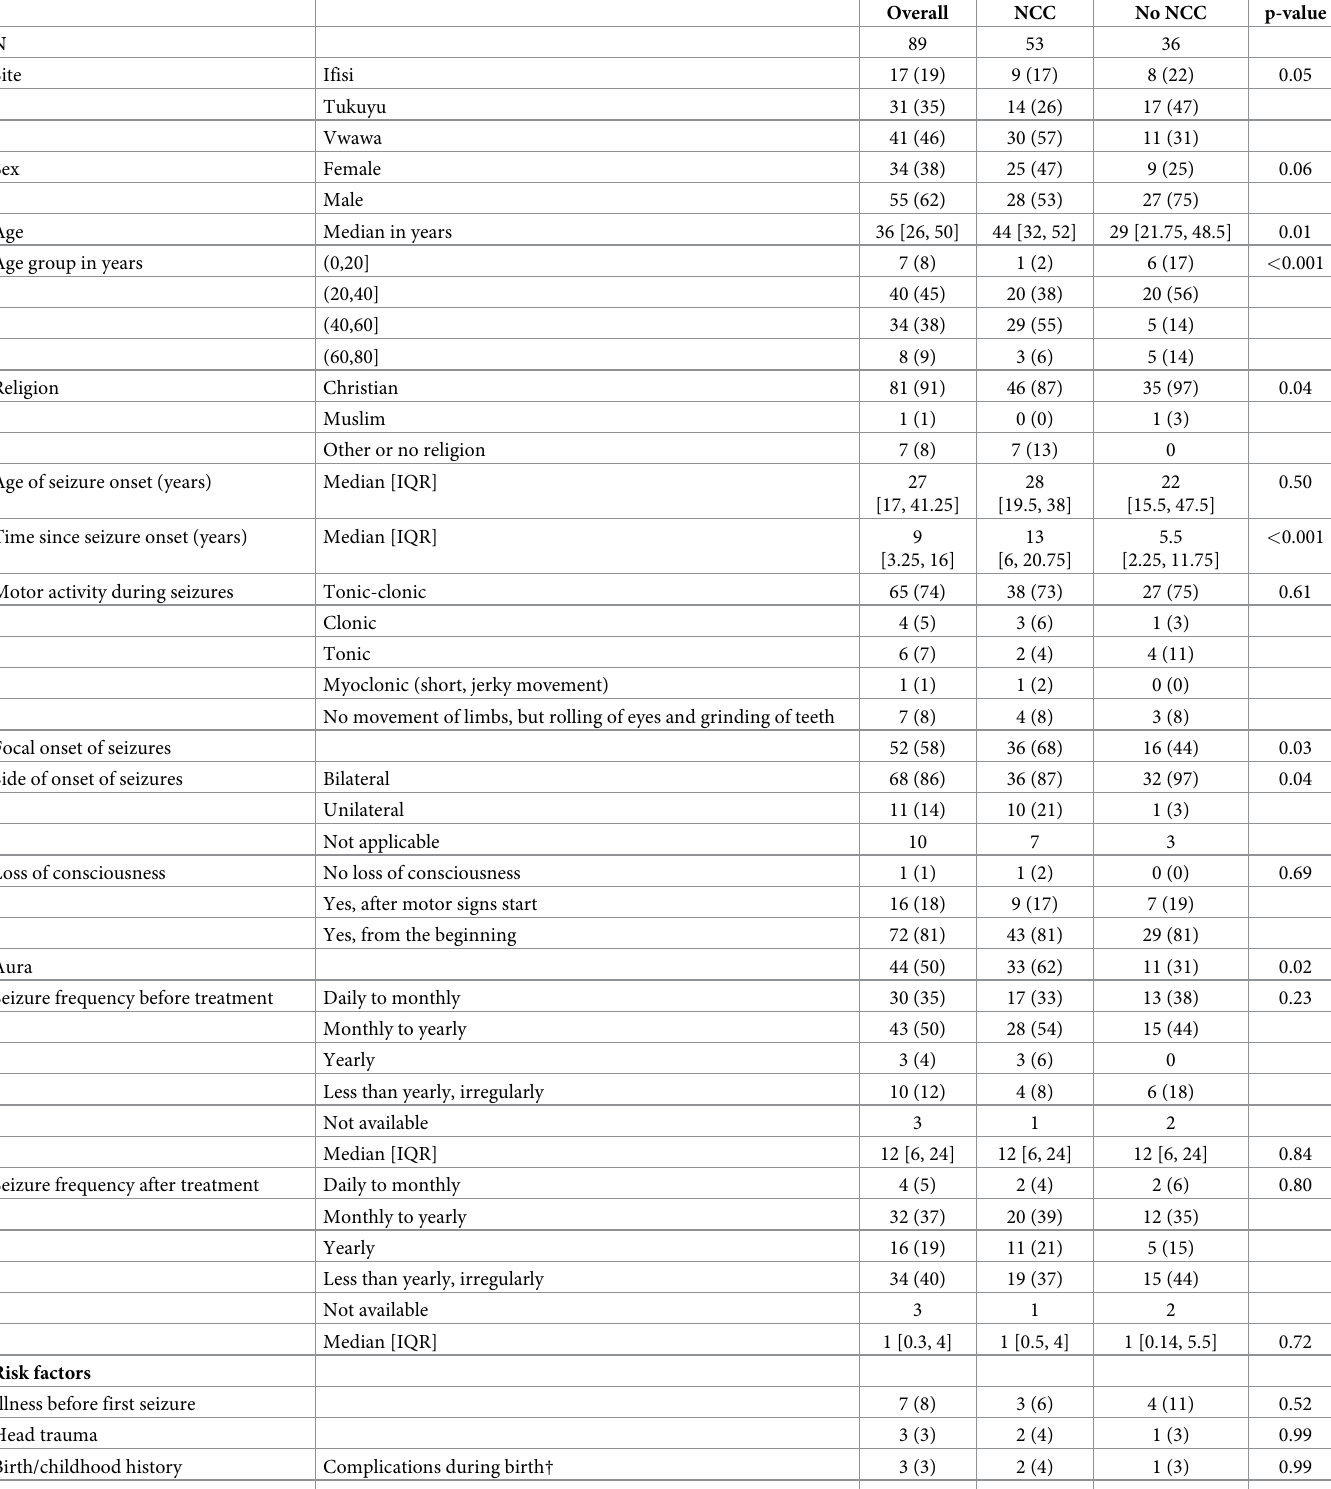
Table 3. Demographic and clinical characteristics of people with epileptic seizures with and without